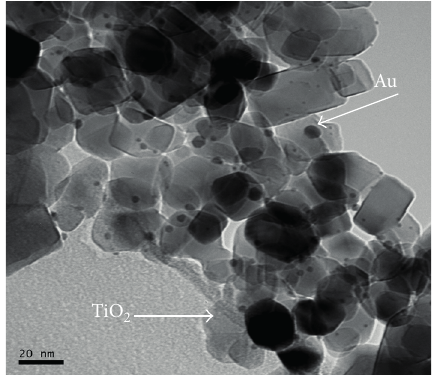
Figure 1: SEM image of gold particles dispersed on TiO 2